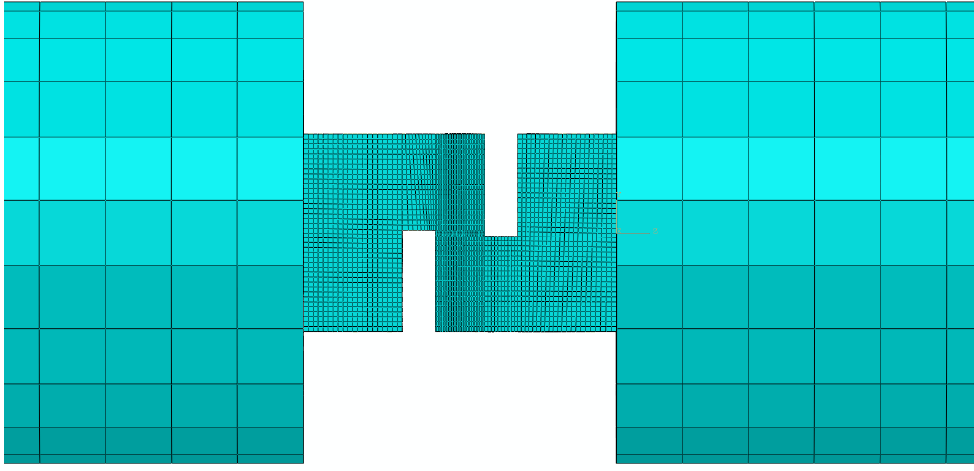
Figure 4. FEM meshes for the NSSS.